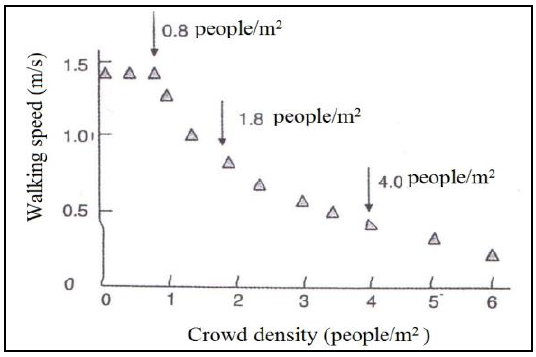
Figure 2. Walking speeds depending on the crowd